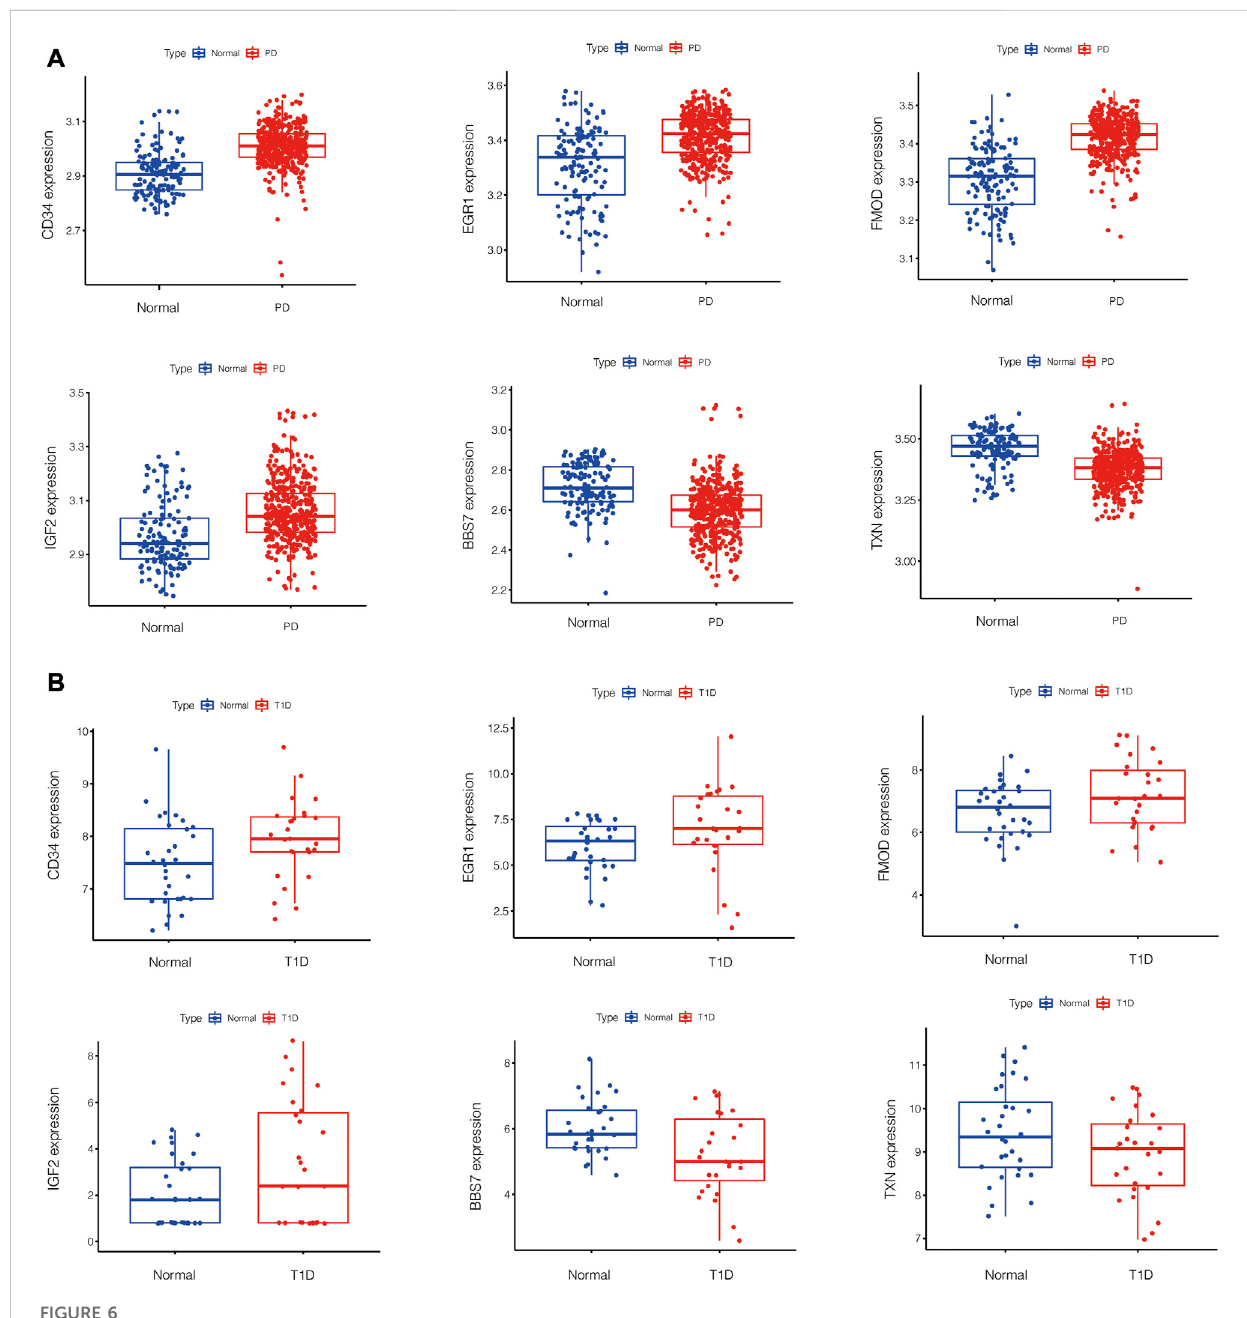
FIGURE 6 Box plots of hub genes expression in PD (A) and T1D (B)